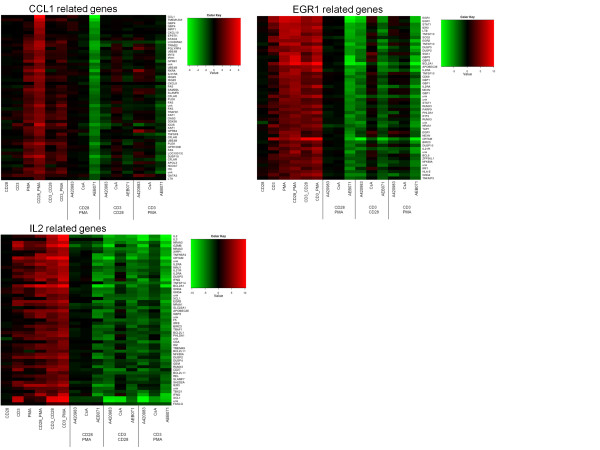
Heatmap of stimulation dependent gene clusters. Top left panel: CCL1 cluster characterized by induction of genes exclusively following CD28/PMA stimulation and subsequent repression by AEB071. Bottom left panel: IL-2 cluster characterized by induction of genes by all stimulations, and down-regulated by A420983 and AEB071 and to a lesser extent by CsA. Top right panel: EGR1 cluster characterized by induction of genes by all stimulations, but down-regulated only by AEB071 when stimulated with PMA/CD28 or PMA/CD3. A red color denotes an up-regulation, a green color a down-regulation. The MAPK inhibitors induced very little regulation and have been omitted from this figure for clarity. The gene lists shown in this figure, with extended annotation and their distance to the CCL1, IL-2 and EGR1 profiles are provided in Additional files: File S1, S2 and S3.